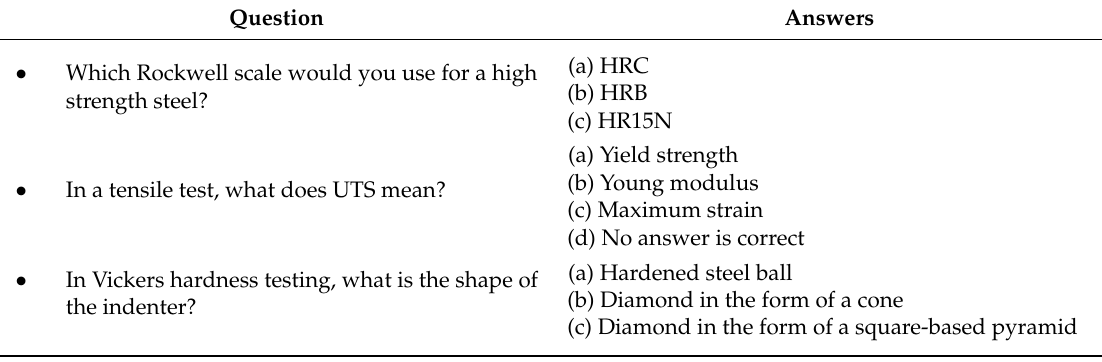
Table 2. Examples of questions and answers included in our student surveys.